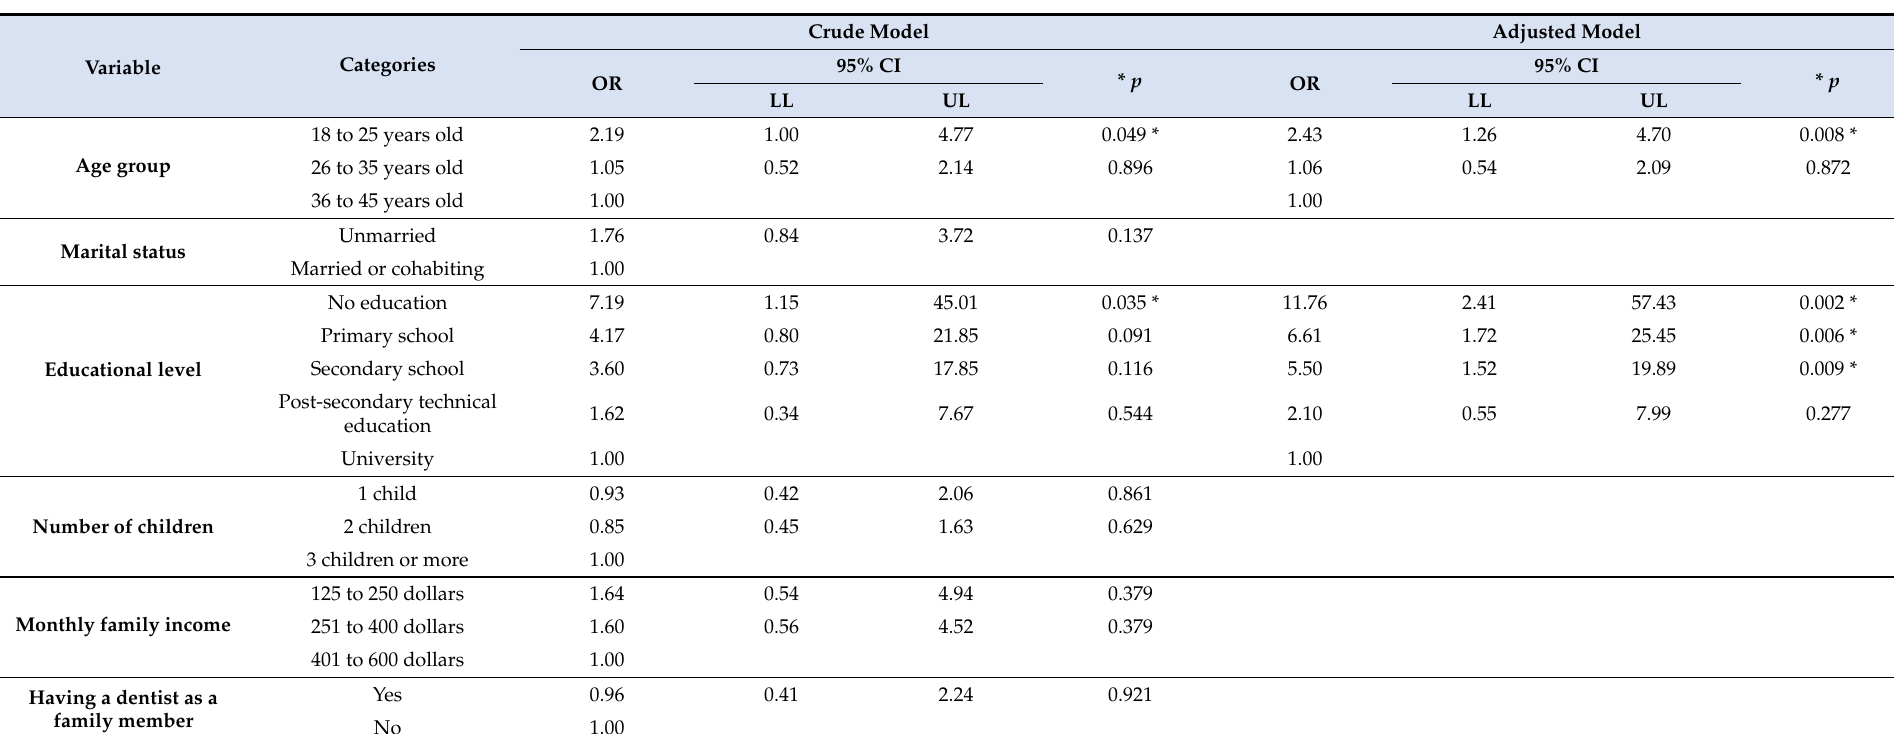
Table 6. Logistic regression model of overall knowledge about oral health prevention in infants aged 0 to 2 years old, according to associated factors. Crude